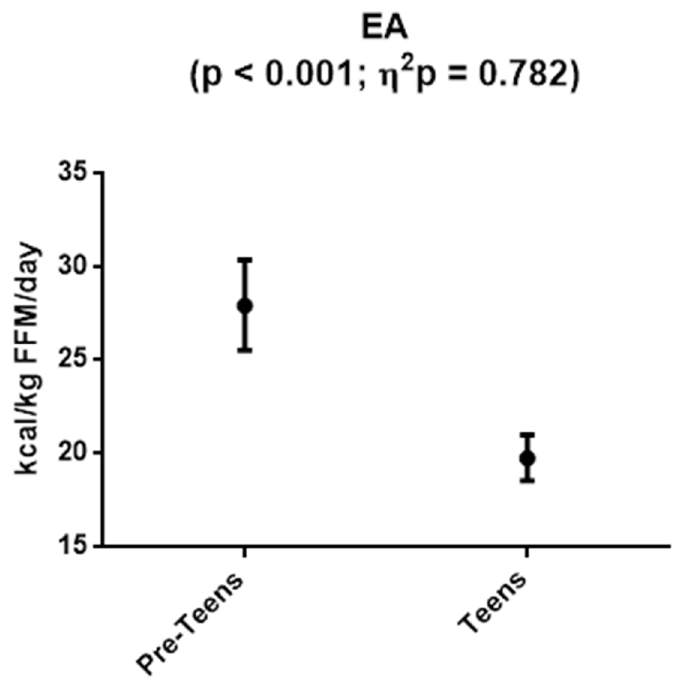
Figure 2. Energy availability values in pre-teen and teen gymnast groups. Data are expressed as mean ± standard deviation. p : p -value for differences between groups by univariate test ( p < 0.05 being considered significant).